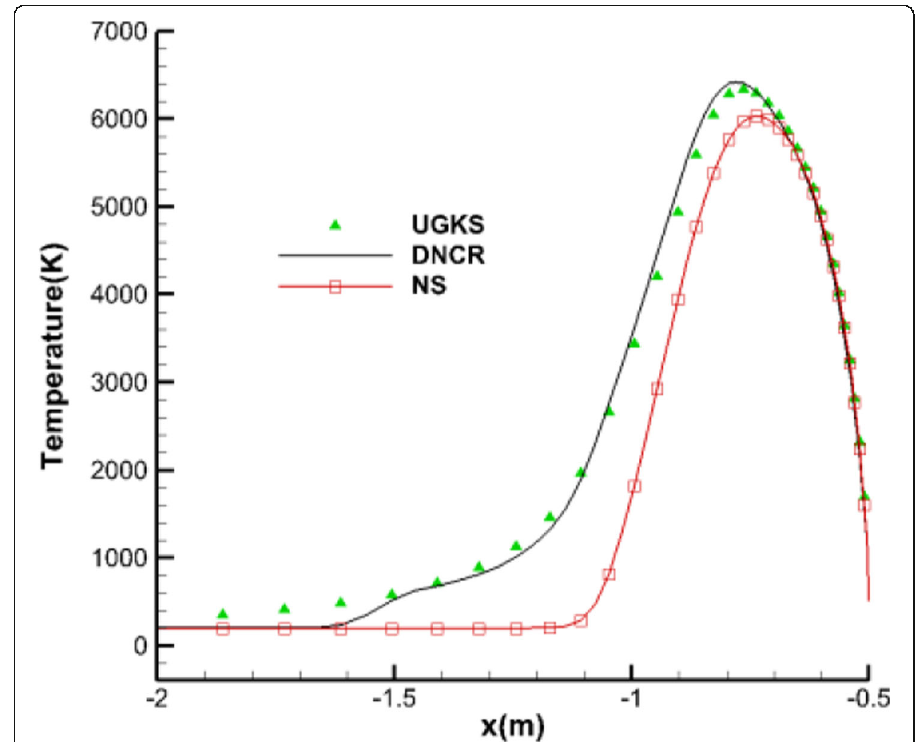
Fig. 13 Temperature distribution along the stagnation